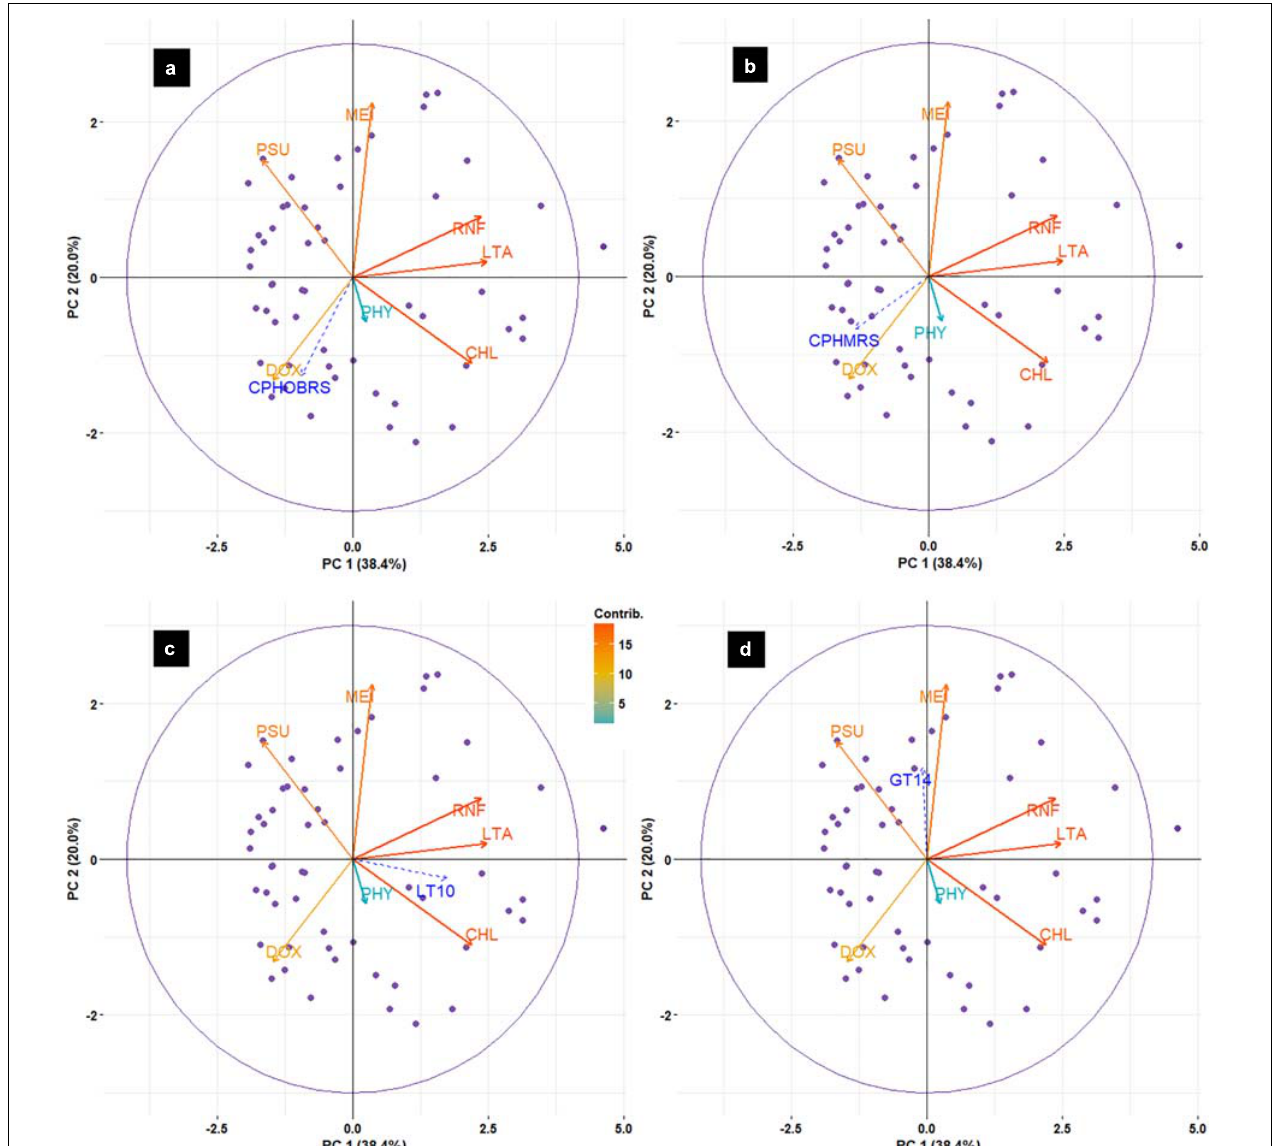
FIGURE 12 | Biplot of principal component analysis (PCA) for environmental data and oil sardine abundance [CPHOBRS (a) and CPHMRS (b) ], recruitment [LT10 (c) ] and maturity [GT14 (d) ] in southeastern Arabian